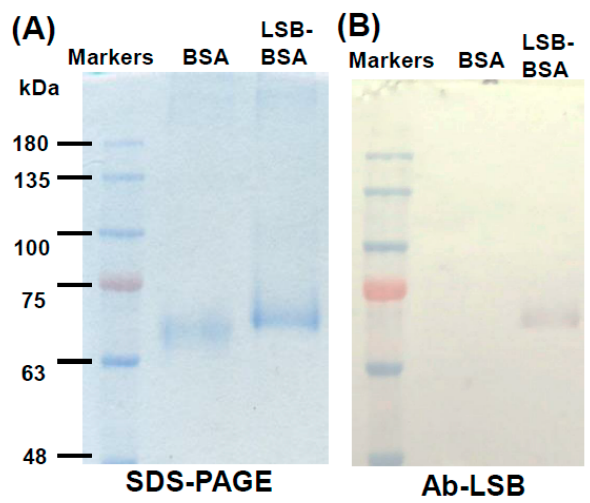
Figure 3. SDS-PAGE and Western blotting of BSA conjugated with or without LSB. BSA conjugated with or without LSB was resolved in SDS-PAGE ( A ), and a duplicate gel was transferred onto PVDF membrane and then subjected to immunoassay using Ab-LSB ( B ). Molecular masses of commercial marker proteins (Genemark, Taichung, Taiwan) were indicated on the left.